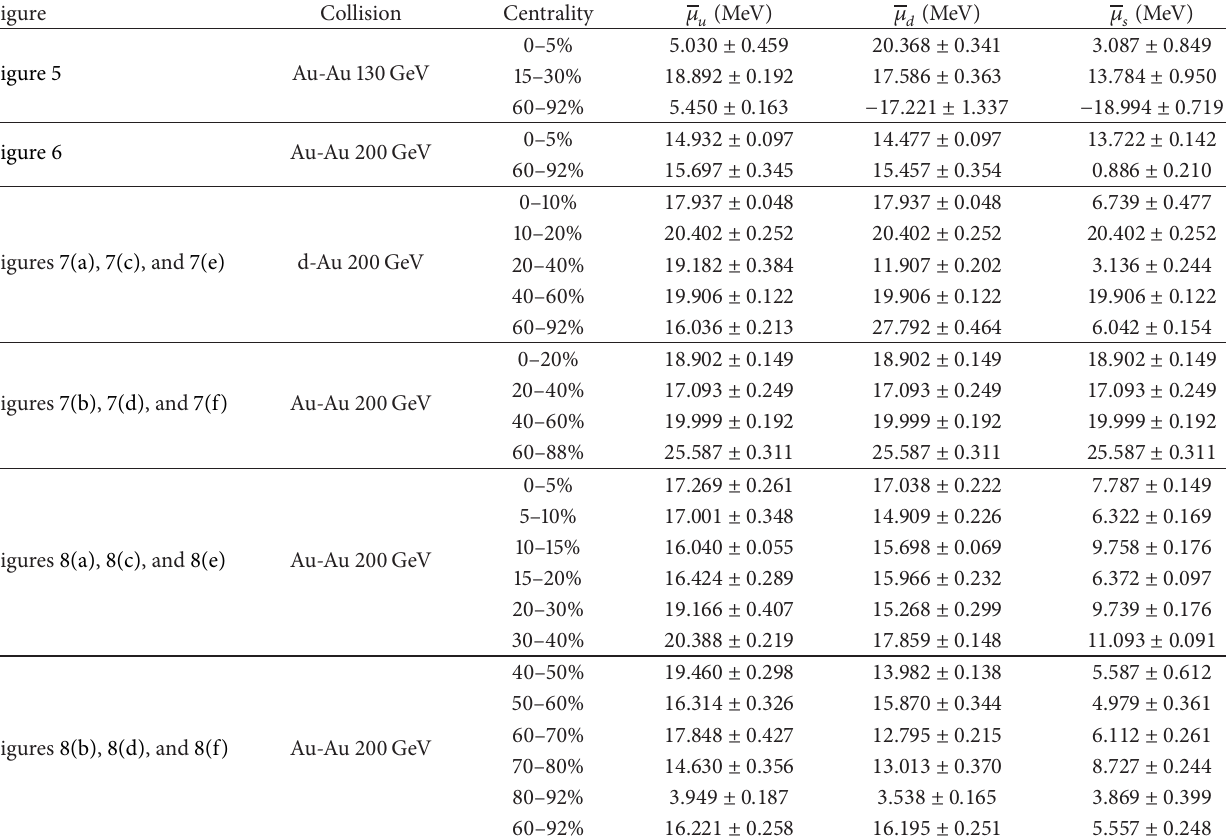
Table 4: Mean values ( 𝜇 𝑢 , 𝜇 𝑑 , and 𝜇 𝑠 ) of chemical potentials obtained from the curves in Figures 5–8, where the errors are the standard